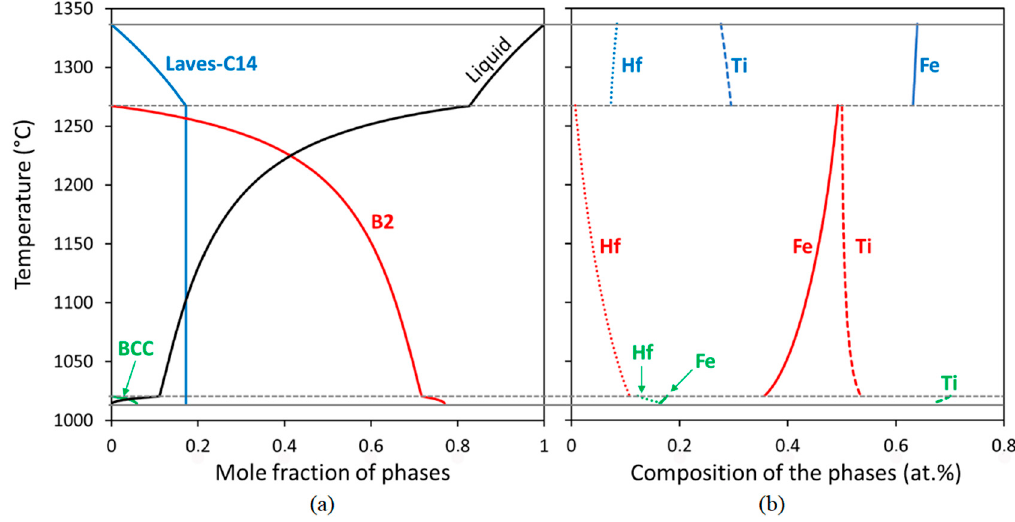
Figure 4. ( a ) Molar fractions and ( b ) composition (at.%) of the phases (Liquid, Laves-C14, B2 and BCC) Figure 4. (a) Molar fractions and (b) composition (at.%) of the phases (Liquid, Laves-C14, B2 and BCC) formed during non-equilibrium solidification of the TiFe 16 wt.% Hf alloy. formed during non-equilibrium solidification of the TiFe 16 wt.% Hf alloy.